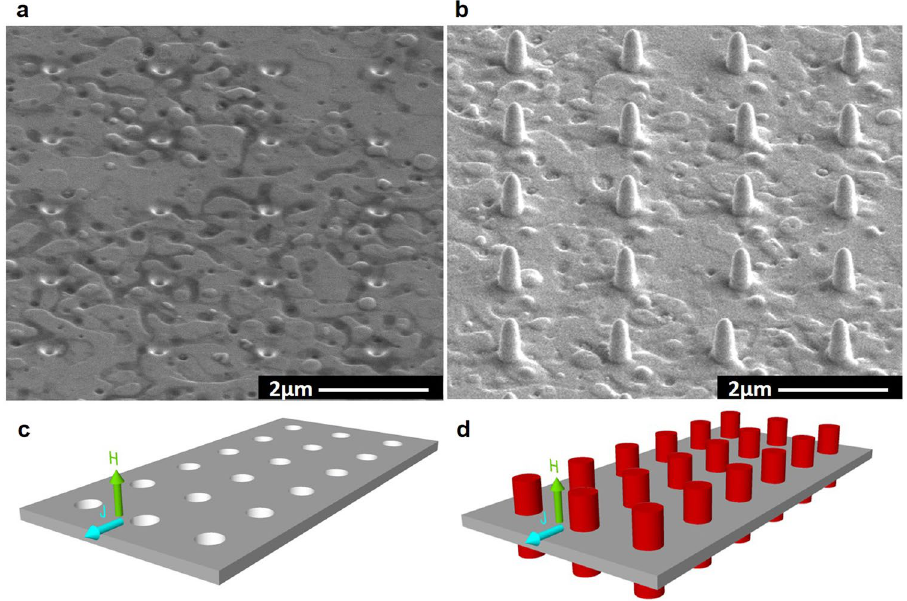
Figure 1. Sample description. Tilted SEM pictures of YBCO transport bridges patterned with an array of ( a ) antidots ( b ) antidots filled with Co nano-rods. ( c ) and ( d ) Schematic representation (not at scale) of transport bridges shown in ( a ) and ( b ), respectively, with the direction of applied electric current and magnetic field